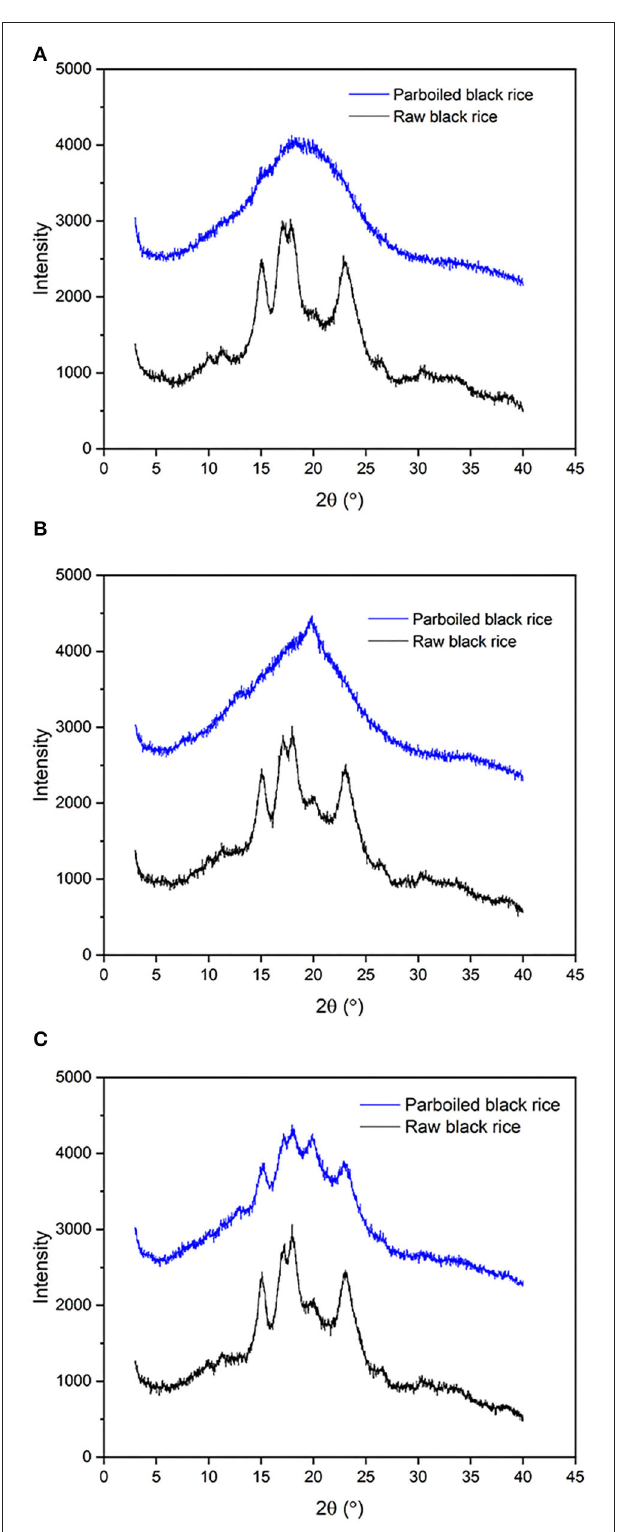
FIGURE 2 | X-ray diffraction (XRD) patterns of raw and parboiled black rice. (A) waxy black rice; (B) medium-amylose black rice; (C) high-amylose black